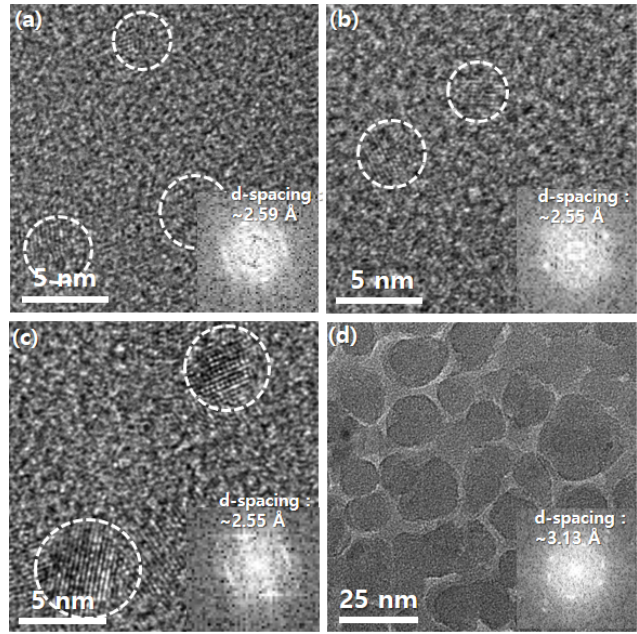
Figure 2. TEM images of SiC nanoparticles on a SiO membrane of a TEM grid at wire temperatures of ( a ) 2300 ◦ C, ( b ) 2200 ◦ C, ( c ) 2000 ◦ C and ( d ) 1800 ◦ C.